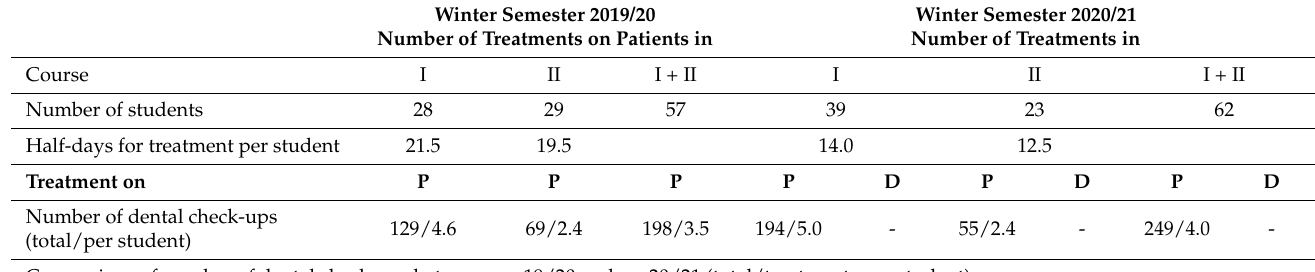
Winter Semester 2020/21 Number of Treatments